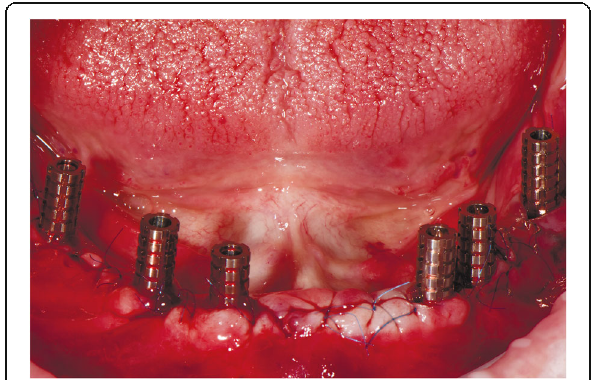
Fig. 13 Interim titanium copings in situ fixed on screw-retained abutments